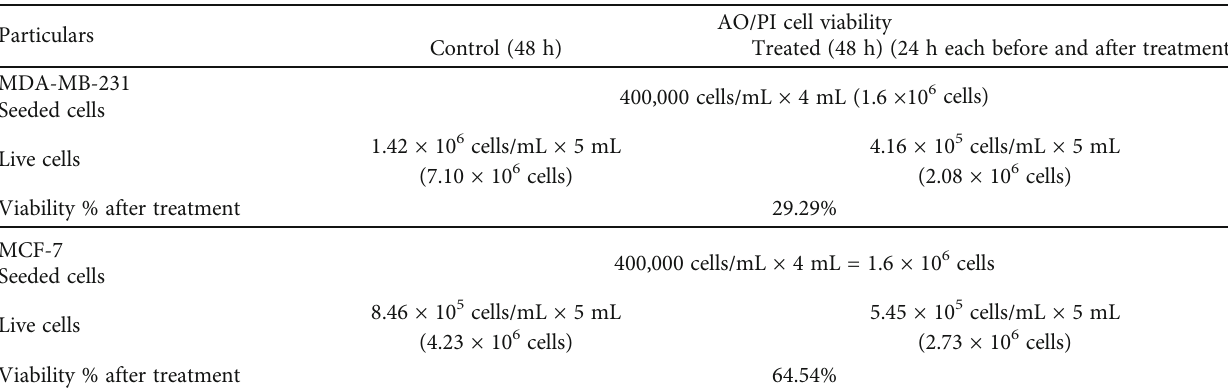
Table 3: Luna AO/PI cell viability